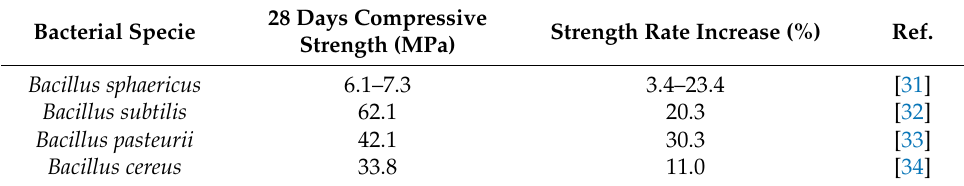
Table 1. Effect of different bacterial species on strength performance of cement materials. Bacterial